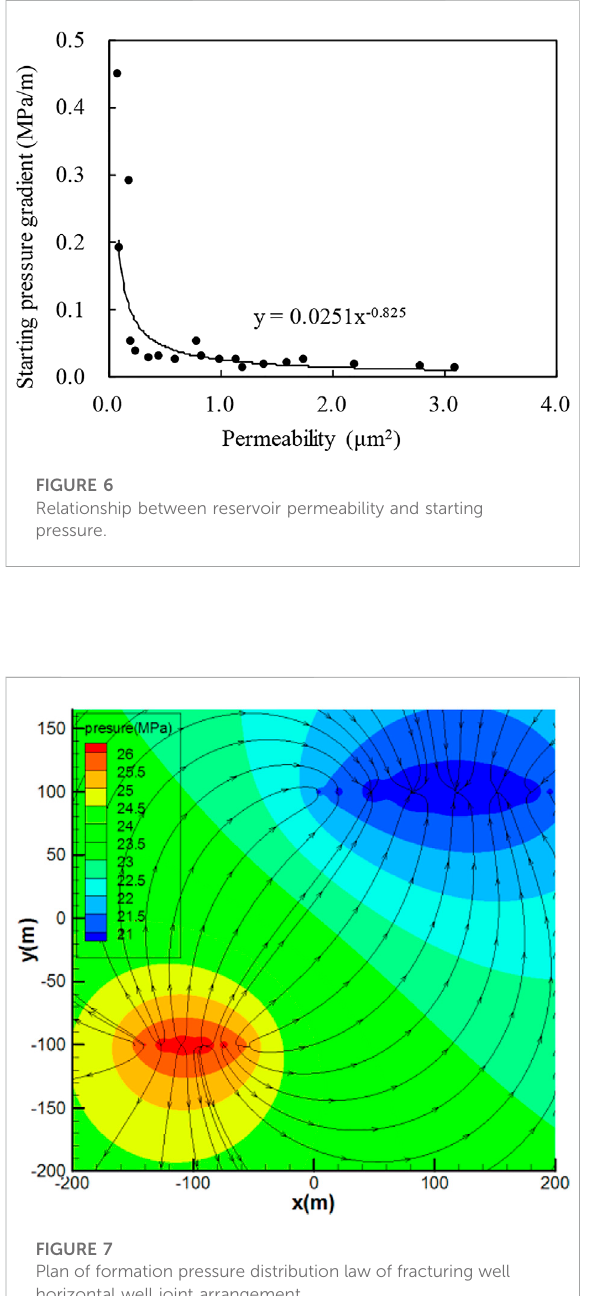
FIGURE 7 Plan of formation pressure distribution law of fracturing well horizontal well joint arrangement.